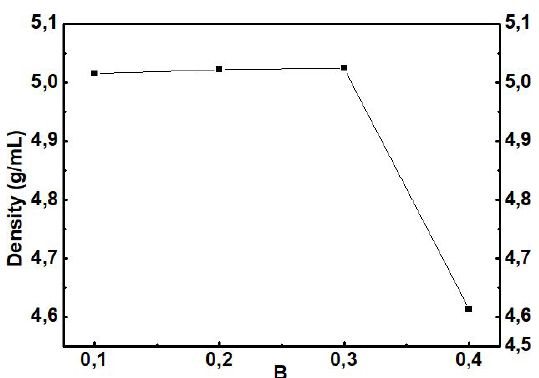
Figure 4. Evolution of the density of pellet samples as a function of